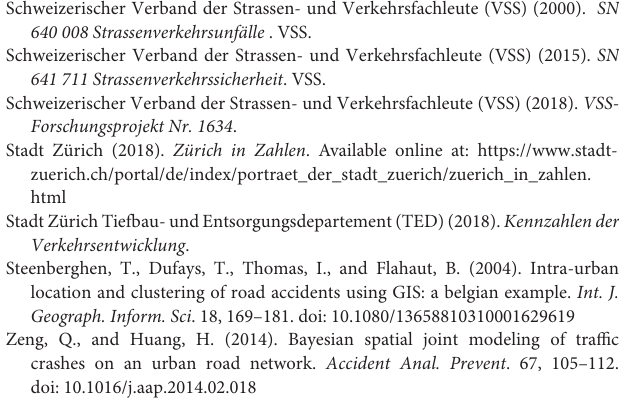
Supplementary Figure 2 | Bike Accidents, District 2. Supplementary Figure 3 | Bike Accidents, District 3. Supplementary Figure 4 | Bike Accidents, District 4. Supplementary Figure 5 | Bike Accidents, District 5. Supplementary Figure 6 | Bike Accidents, District 6. Supplementary Figure 7 | Bike Accidents, District 7. Supplementary Figure 8 | Bike Accidents, District 8. Supplementary Figure 9 | Bike Accidents, District 9. Supplementary Figure 10 | Bike Accidents, District 10. Supplementary Figure 11 | Bike Accidents, District 11. Supplementary Figure 12 | Bike Accidents, District 12. Supplementary Figure 13 | Bike Accidents, Zurich (all